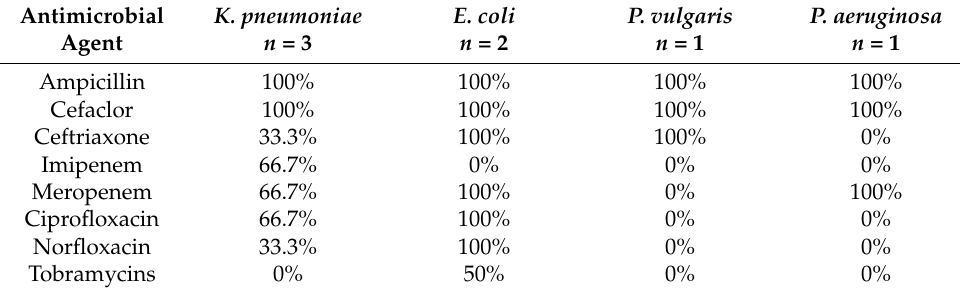
Table 2. Antibiotic resistance profile of isolates from WHH ICU.